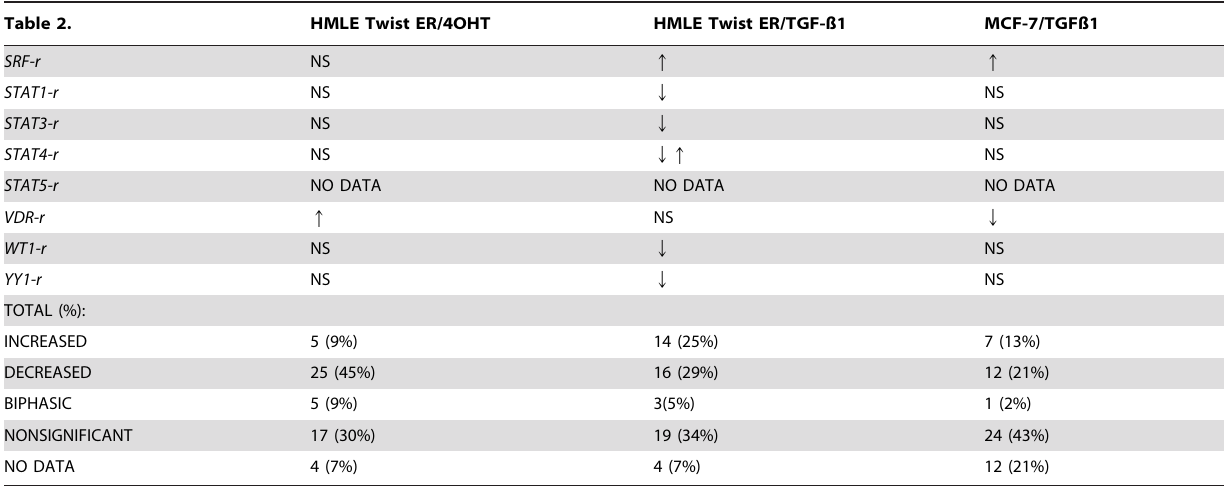
Upward arrows indicate increased activity; downward arrows indicate decreased activity; and NS indicates no significant changes relative to vehicle controls. TF reporters listed as ‘‘no data’’ had signal that was too low to be